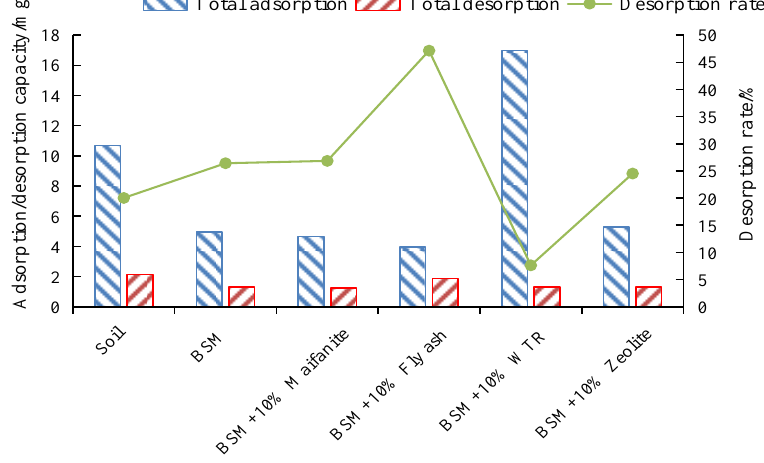
Figure 6. Experimental results of the dynamic desorption of phosphorus in modified fillers.